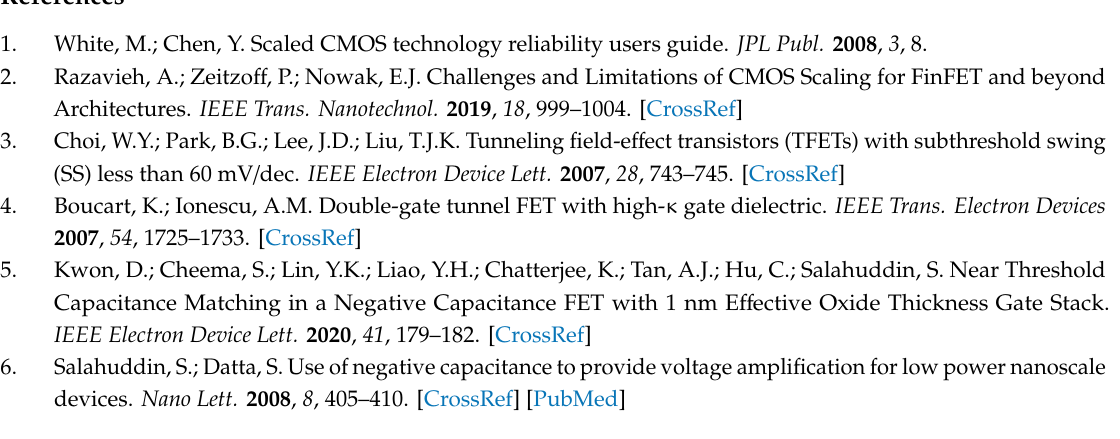
Figure 8. Process flow for the proposed tunnel FET with asymmetric spacers. ( a ) oxide and poly-Si deposition on SOI wafer. ( b ) drain-side patterning by photolithography and etching, low-κ spacer and drain region formations ( c ) oxide passivation on drain-side and poly-Si removal. ( d ) based on nitride spacer formation, oxide and partial silicon etching, then source region and channel epitaxy formation. ( e ) nitride and high-κ spacer formations. ( f ) oxide passivation on source-side and high- κ/metal gate process.